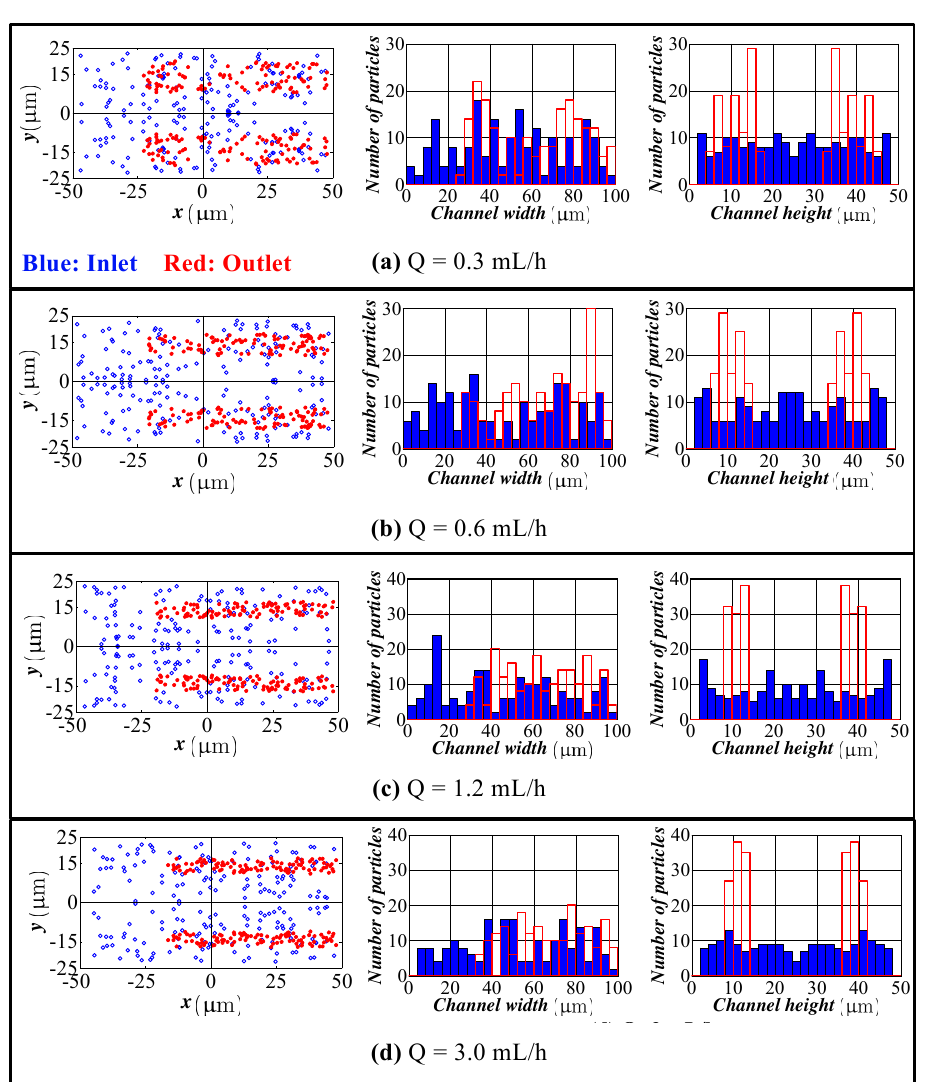
Figure 3. Particle distribution at the inlet and outlet in the height and width directions for different flow rates (spiral channel with an aspect ratio (AR) of 2.0, 1.9 µ m particles). Flow rate: ( a ) 0.3 mL/h; ( b ) 0.6 mL/h; ( c ) 1.2 mL/h; ( d ) 3.0 mL/h. Blue bars: particle distribution at the inlet. Red bars: particle distribution at the